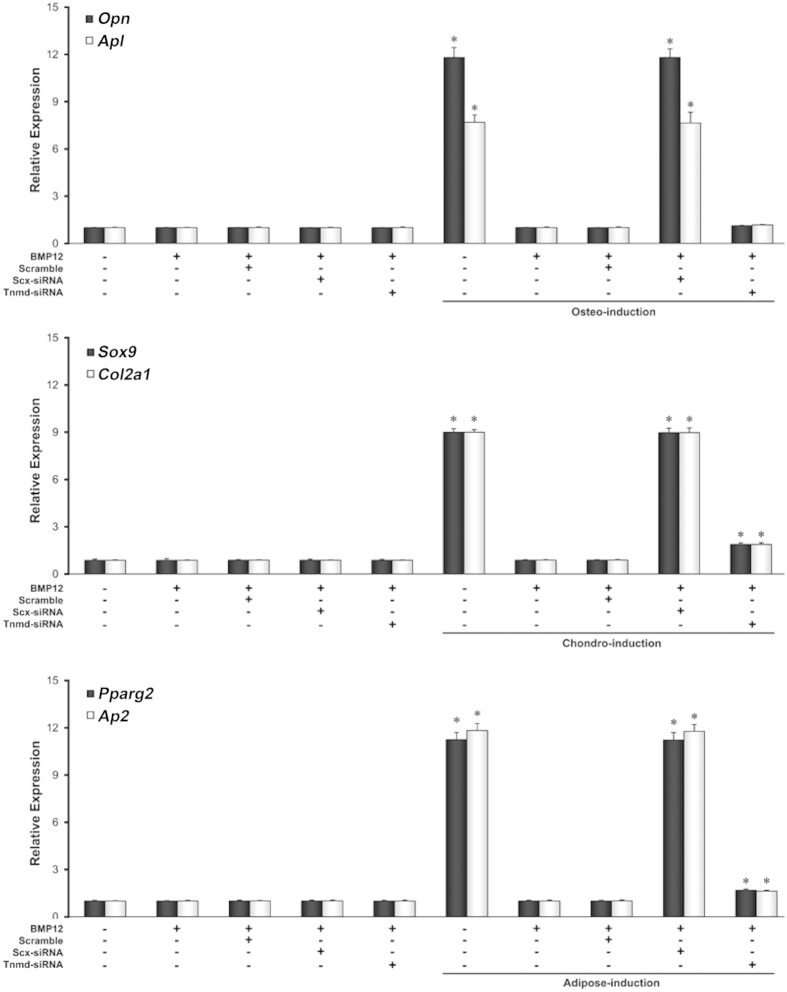
Scleraxis knockdown preserves multi-potent potentials in C3H10T1/2 cells.Untransfected C3H10T1/2 cells or cells transfected with scramble siRNA, or Scx siRNA, or Tnmd siRNA were left untreated or treated with BMP-12 for 24 hours and further incubated for designed length of time in the absence or presence of lineage induction media. The phenotypes (Scx and Tnmd expression) of respective groups of cells and mRNA expression of lineage-specific marker genes were assayed by RT-qPCR. Data are expressed as mean ± S.D. (n = 6). *p < 0.05.